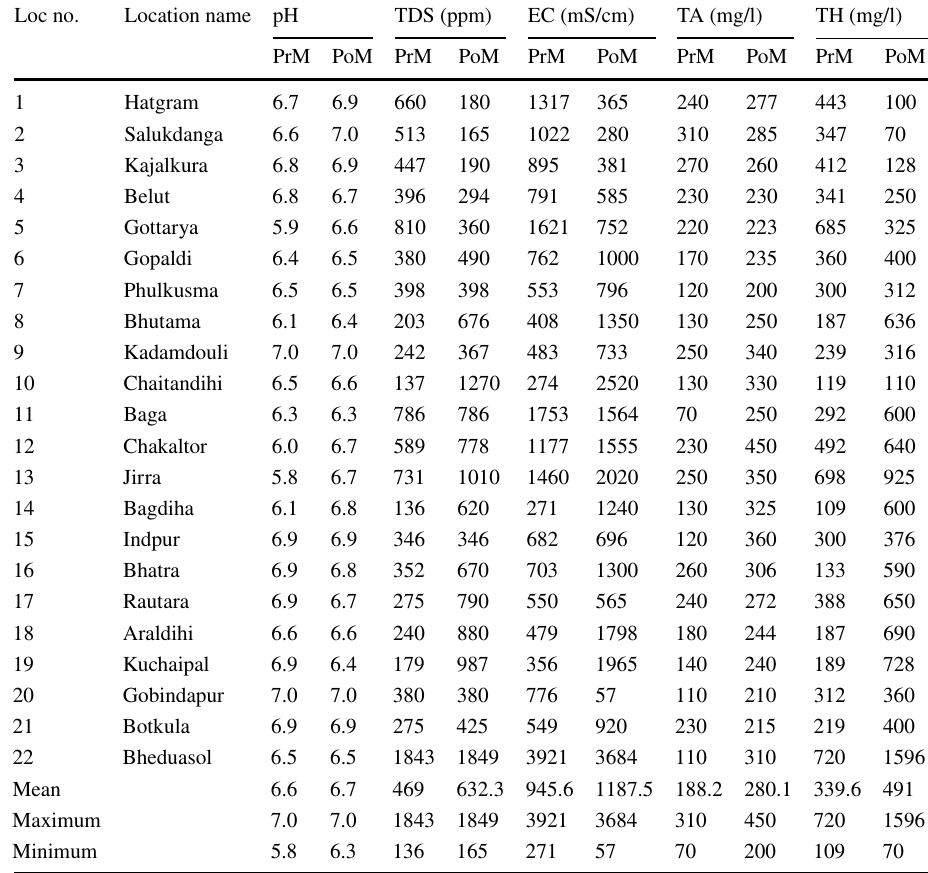
TDS total dissolve solids, EC electrical conductance, TA total alkalinity, TH total